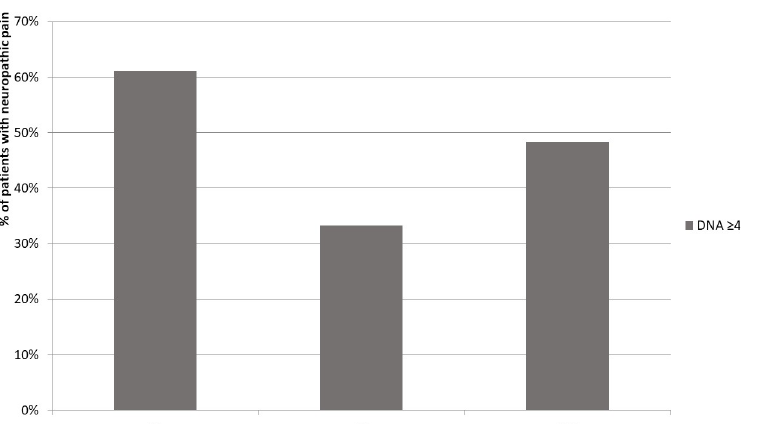
Fig 4. Proportion of patients with neuropathic